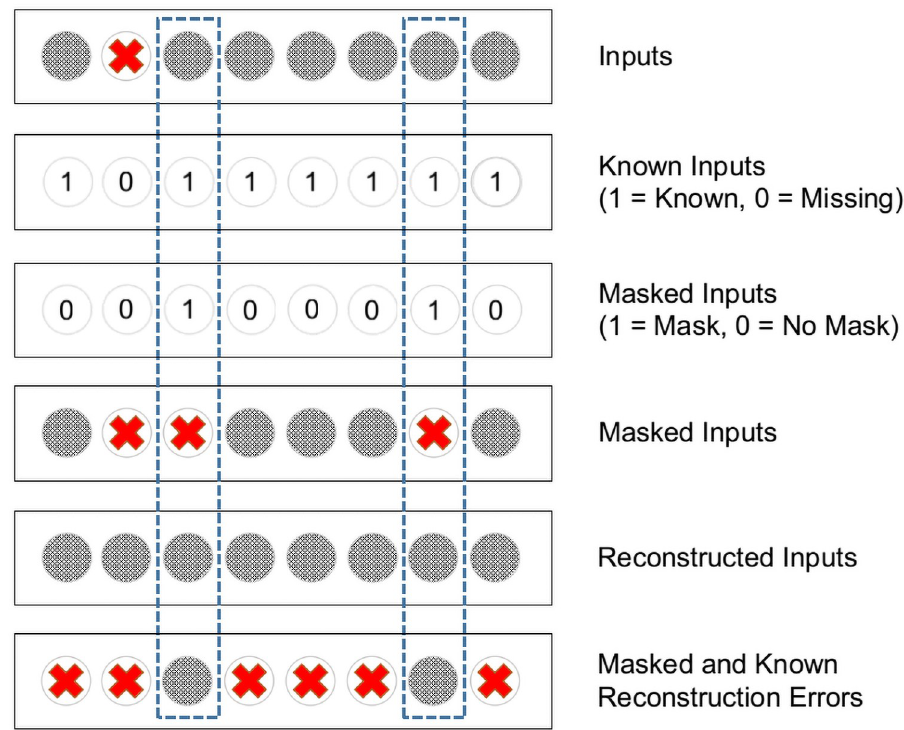
Fig 1. An illustration of how the reconstruction regularization term is calculated, in combination with input masking. The top two rows identify data that is missing in our dataset. The subsequent two rows indicate data that is randomly masked at training time. Dashed lines demonstrate that only values which are both known and masked are used in calculating the reconstruction regularization term.